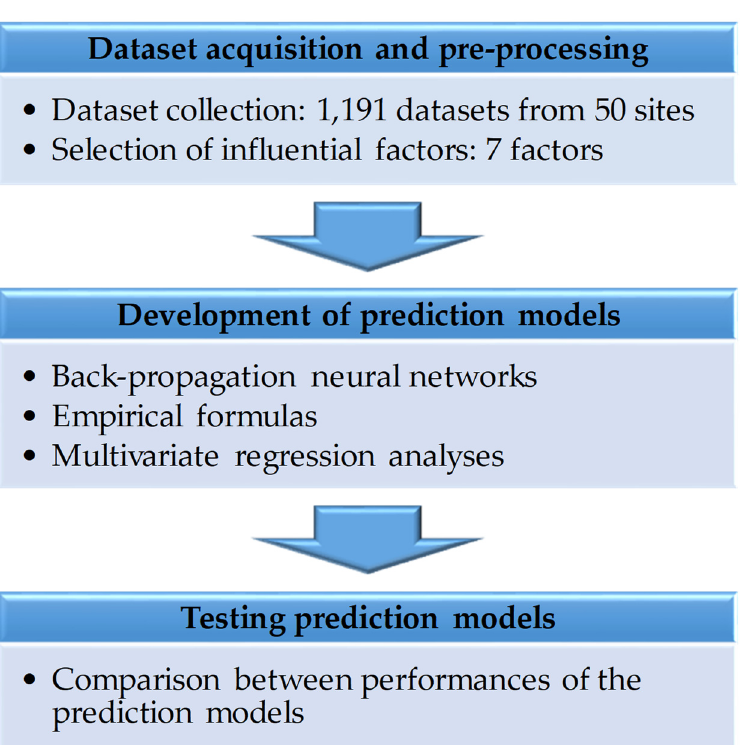
Figure 1. Three steps of the research process.